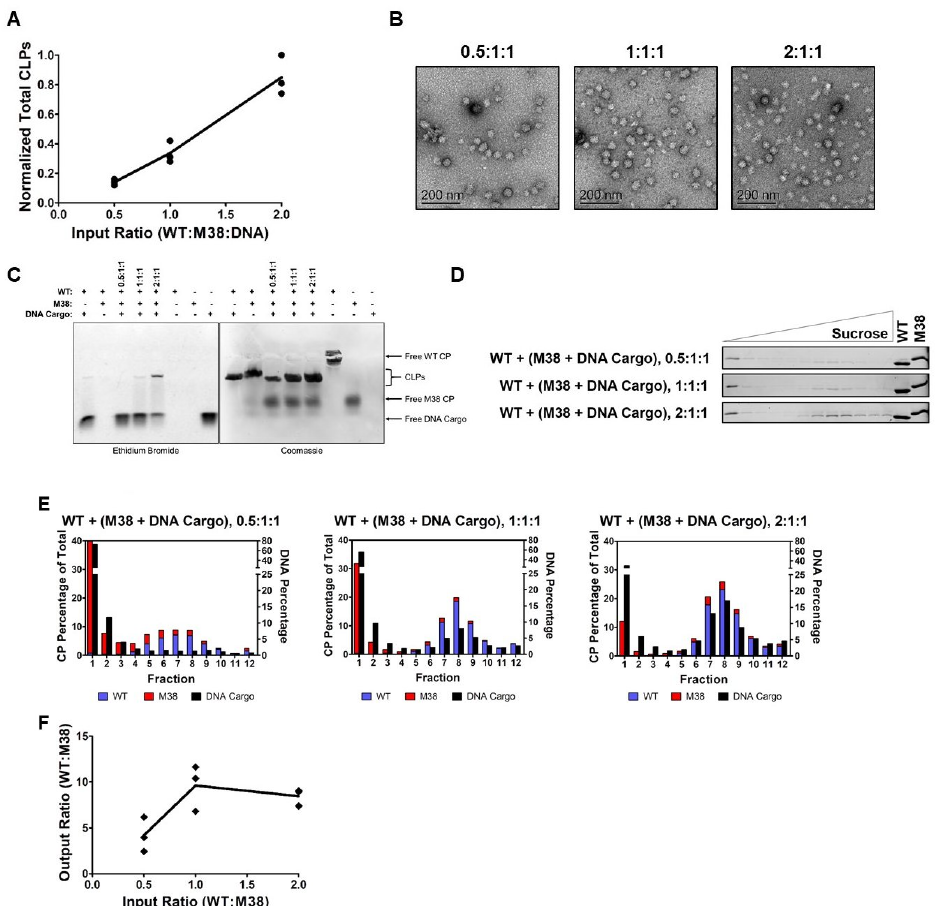
Figure 5. M38 CP competes with DNA for interactions with WT CP and incorporation into CLPs. ( A ) As the input ratio of WT:M38 CP increased, the amount of CLPs formed increased in a linear fashion, as determined by DLS. The line represents the mean of the three biological replicates (circles). The numbers are normalized according to Table 1. ( B ) Negative-stain TEM images of the WT + M38 + DNA cargo CLPs. Addition of DNA cargo did not appear to change the morphology of the CLPs. ( C ) Native gel-shift analysis of the unpurified CLP reactions. The WT + DNA cargo and WT + M38 reactions were assembled at a 1:1 molar ratio and the ratios for the WT + M38 + DNA cargo lanes are shown above the gel. ( D ) Separation of WT + M38 + DNA cargo CLPs over a sucrose gradient by ultracentrifugation. The gels are representative of three biological replicates. The control lanes were loaded with 1.5 μ g concentrated protein. ( E ) Quantification of the protein and nucleic acid content in the fractions from the gels in ( D ). Protein content was quantified using densitometry, and nucleic acid content was quantified using fluorescence. Each data point was normalized so that the total protein signal in each graph would equal 100% and total DNA signal would equal 100%. ( F ) As the input ratio of WT:M38:DNA cargo increased, the output ratio increased up to a ratio of 1:1:1, but then plateaued at a ratio of 2:1:1 as determined from the ratio in fraction 8 (peak fraction). The amount of M38 CP incorporated decreased when DNA was added to the CLPs.